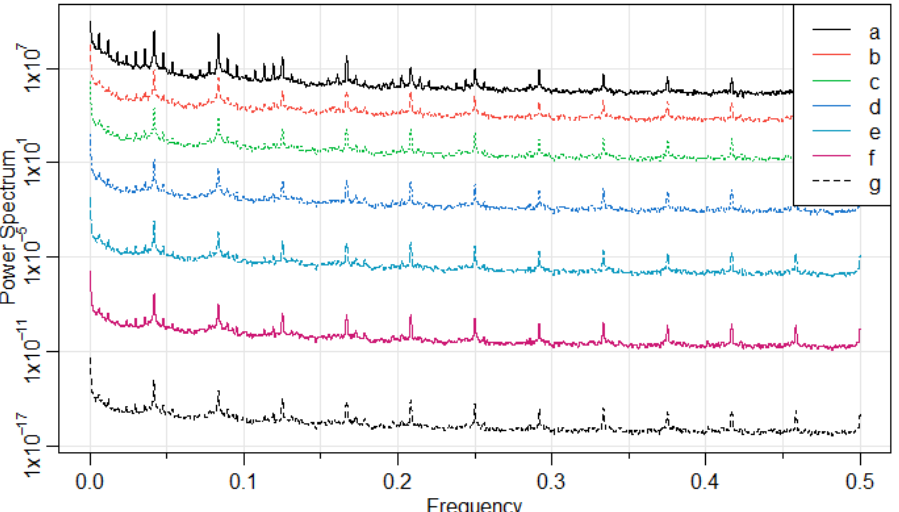
Figure 5. Calculated power spectrum for the market curve